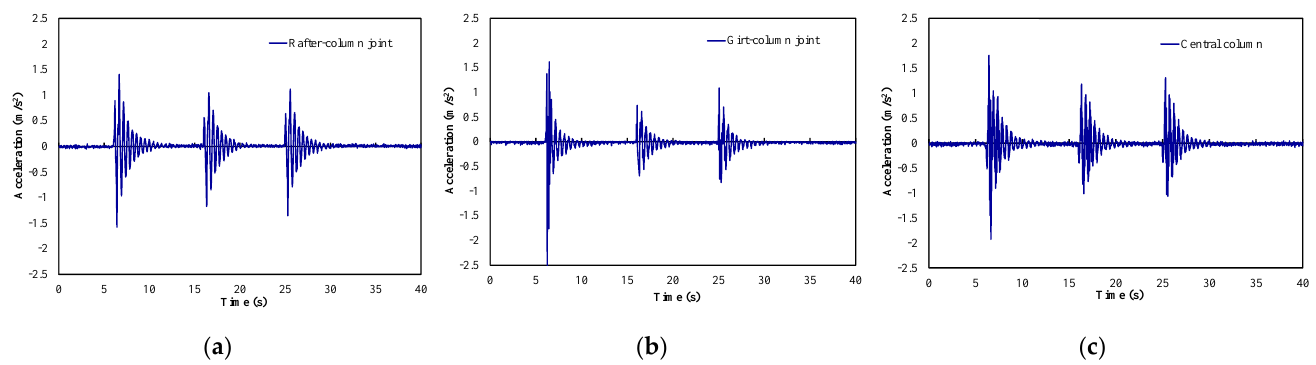
Figure 10. Recorded acceleration time histories at the ( a ) rafter-column joint; ( b ) girt-column joint; and ( c ) central column.